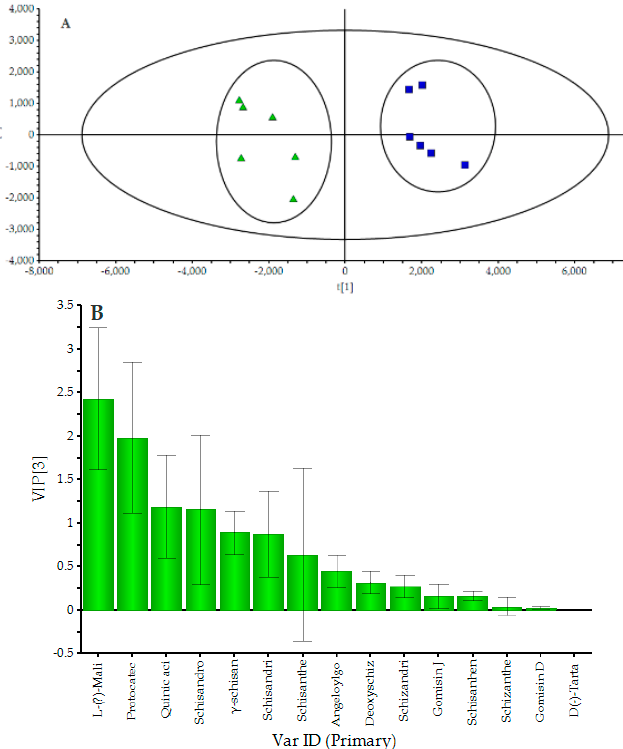
Figure 4. Score scatter plot ( A ) and VIP ( B ) by PLS-DA processed data obtained from wild and cultivated wuweizi scanned by positive and negative ion mode.